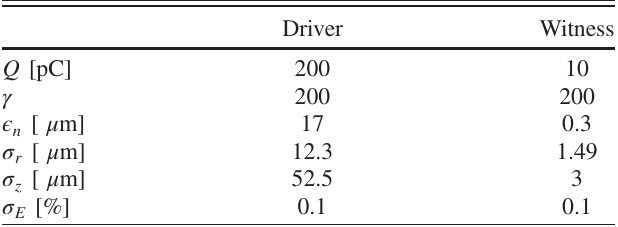
TABLE IV. Working point n p ¼ 1 × 10 16 cm − 3 .